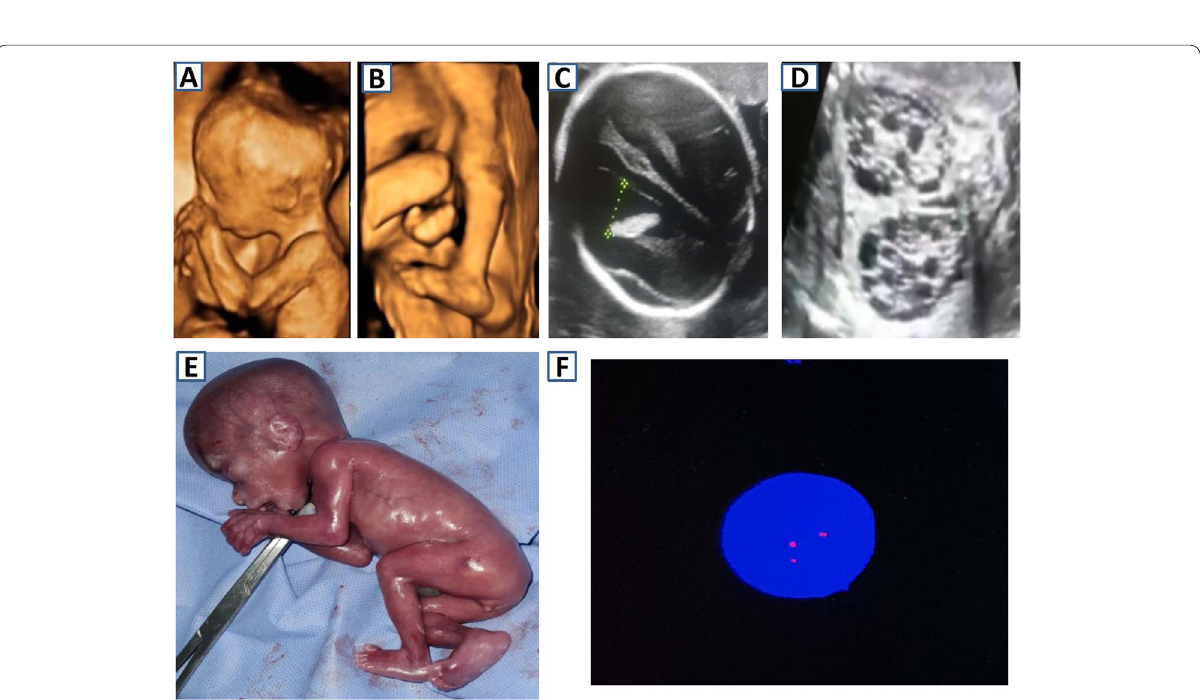
Fig. 2 A case of trisomy 18 detected in the second trimester. A Three‑dimensional surface rendering of the fetal face showing low set ears and clenched hands. B Three‑dimensional surface rendering mode of the lower extremities showing bilateral rocker‑bottom feet. C Axial transventricular plane of the fetal head showing ventriculomegaly. D Coronal ultrasound image of a multicystic dysplastic kidney (MCDK) showing several subcortical small cysts. E Postmortem image confirms the presence of the above findings. F FISH technique showing trisomy